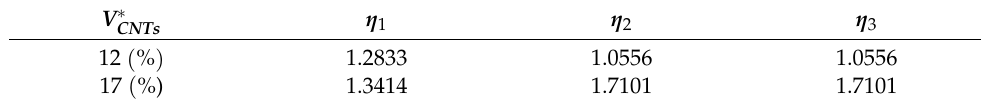
Table 2. SWCNTs efficiency